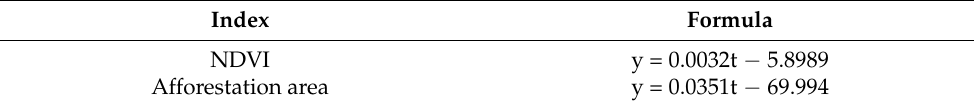
Table 2. The NDVI and afforestation area inter-annual trend line